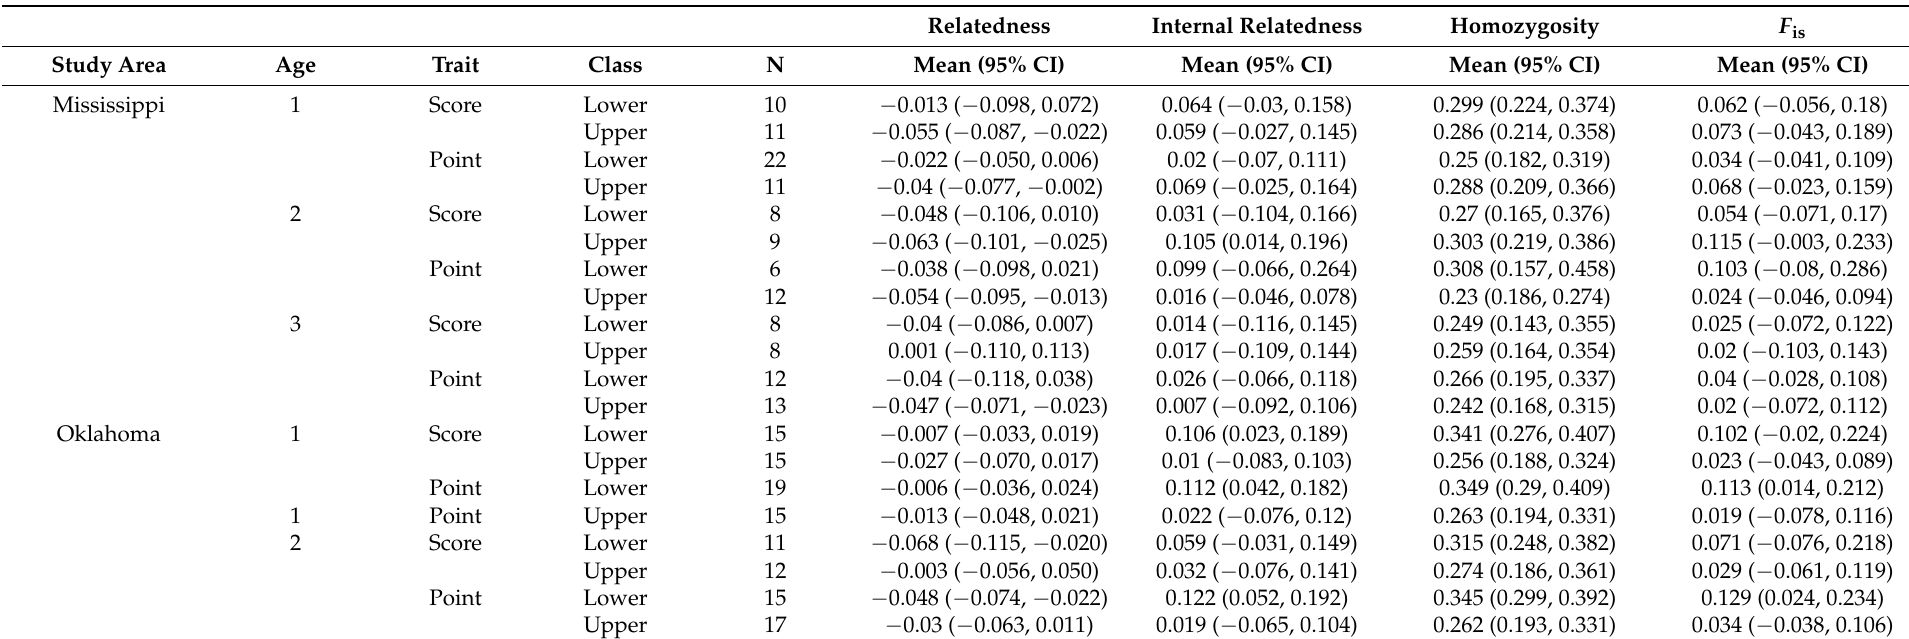
Table A1. Relatedness ( r ), internal relatedness (IR), homozygosity weighted by locus (HL), and F is among male white-tailed deer ( Odocoileus virginianus ) within age class for lower and upper antler point and score (cm) quartiles and presence ( ≥ 2) or absence of non-typical points and antler malformations from Mississippi (1999–2001), Oklahoma (1991–2005) and Texas